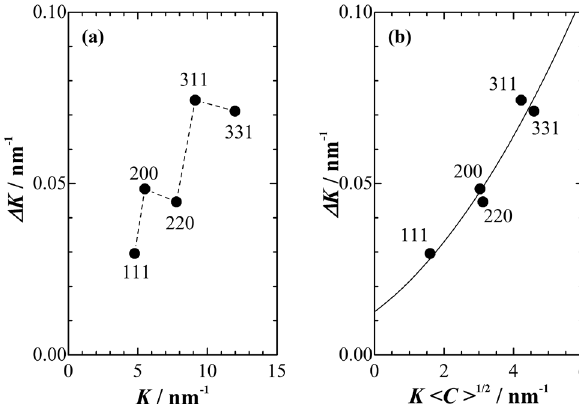
Fig. 2: (a) Classical and (b) modified Williamson-Hall plots of the diffraction profile of ST + CR specimens before